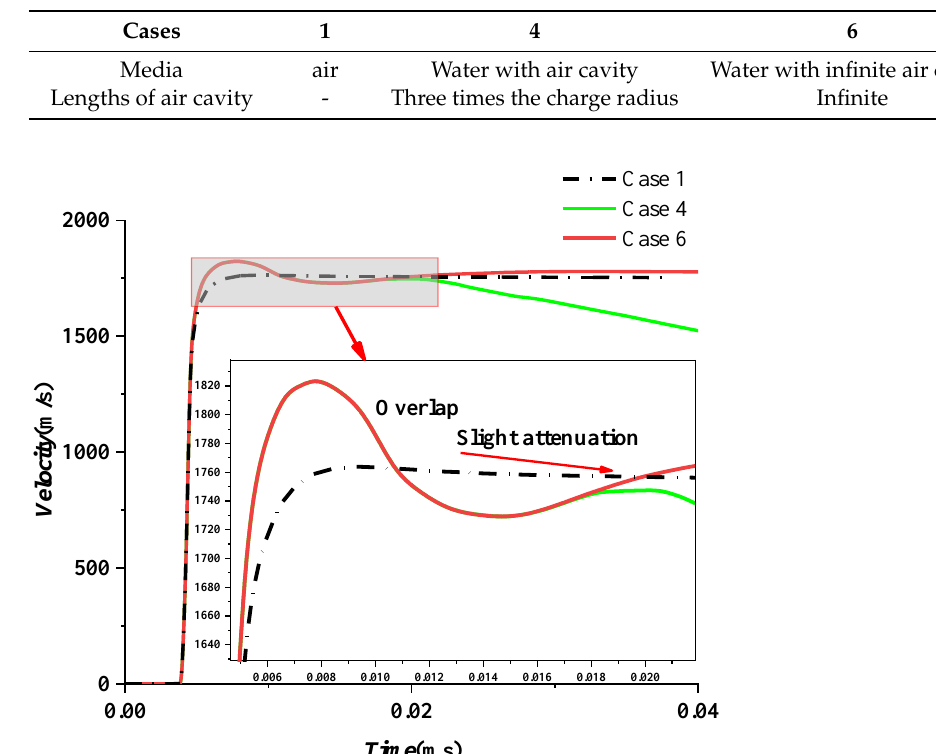
Figure 19. Comparison analysis diagram of the pitting stage and maximum velocity.